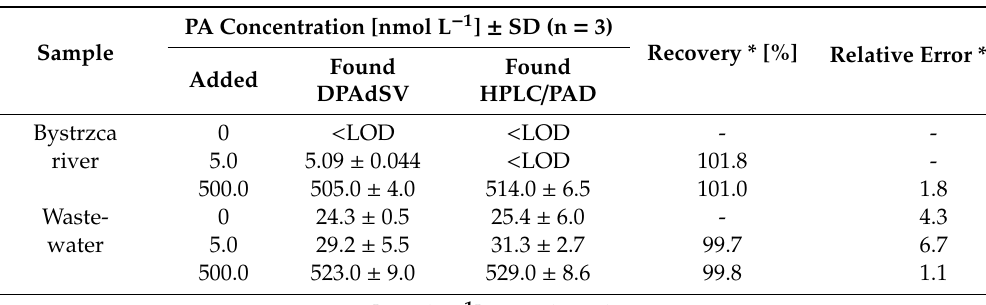
Table 3. Results of simultaneous determination of PA and DF in environmental water samples. DPAdSV, di ff erential-pulse adsorptive stripping